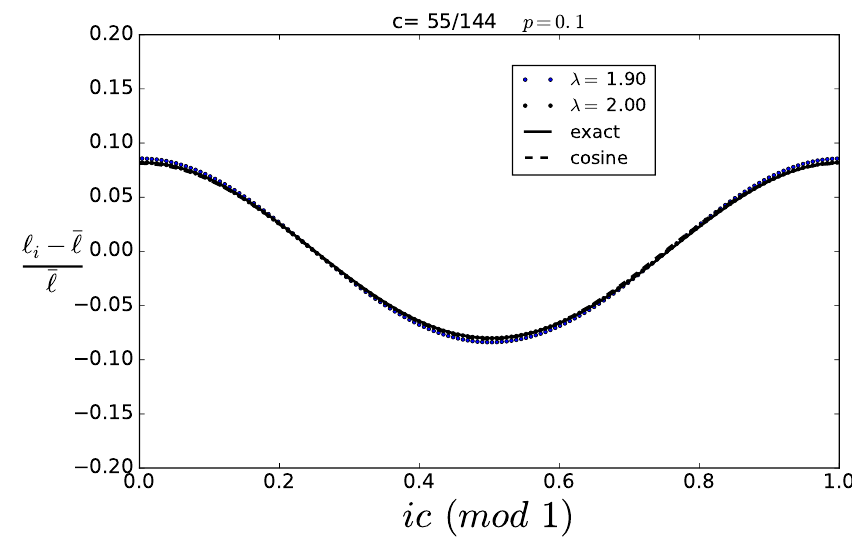
Figure 21: Envelope function of the incommensurate CDW at strong pressure ( p = 0.1), in the integrable case, λ = 2 and nonintegrable case λ = 1.9. Here ξ = 2. In full line, exact result from Eq. (134) with q = 0.0225 and cosine from Eq.